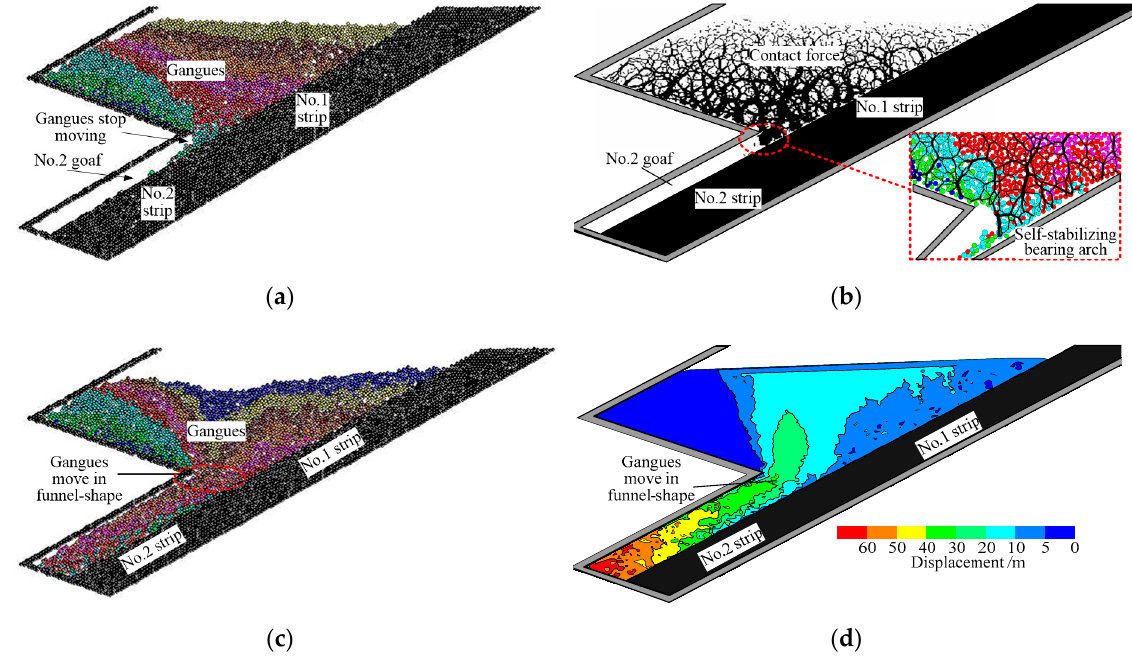
Figure 8. Gangue backfilling characteristics at the funnel-shaped subsidence stage: ( a ) backfilling form, ( b ) contact force distribution after the working face advanced 80 m, ( c ) backfilling form, and ( d ) displacement distribution after the working face advanced 100 m.